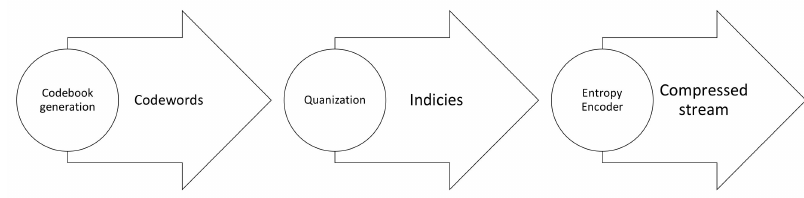
Figure 14. Main steps used in VQ-based class of compression algorithms of